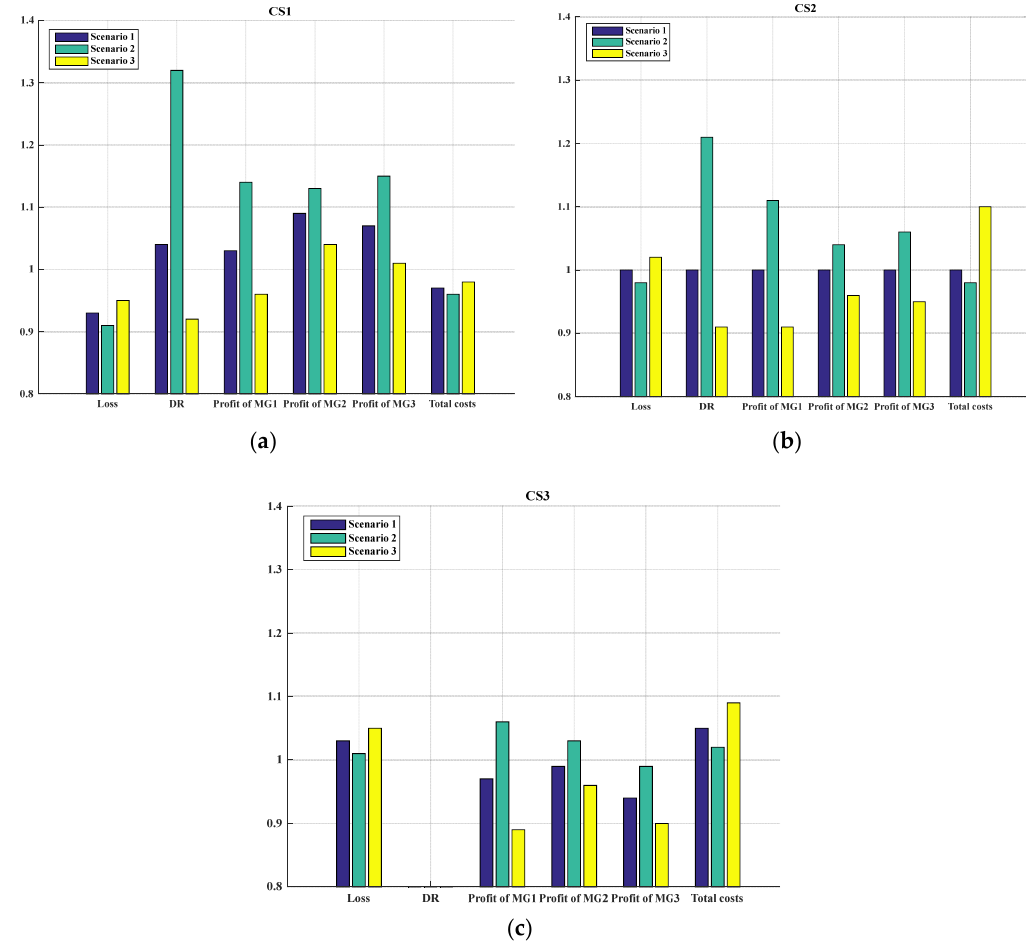
Figure 12. Comparison of technical and financial results between: ( a ) CS1; ( b ) CS2 and ( c ) CS3.